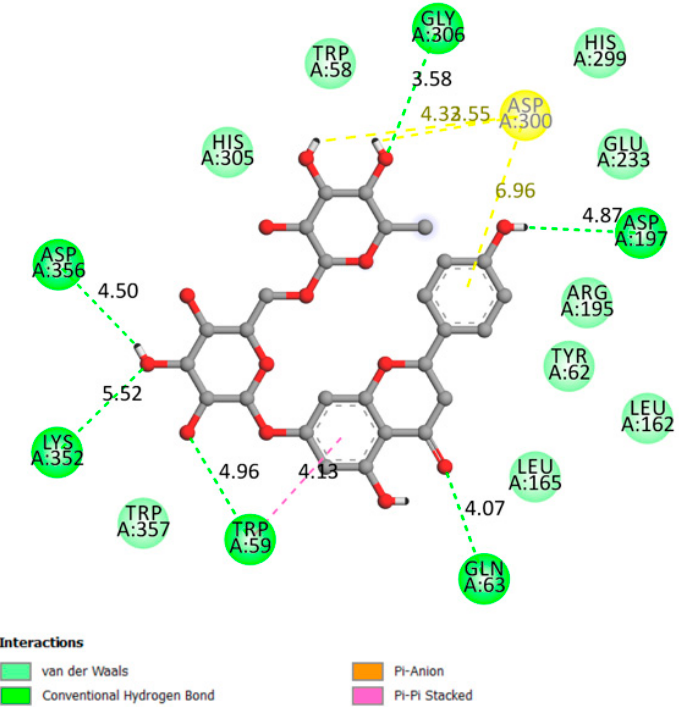
Figure 5. Two-dimensional scheme of the narirutin interactions with AAM.